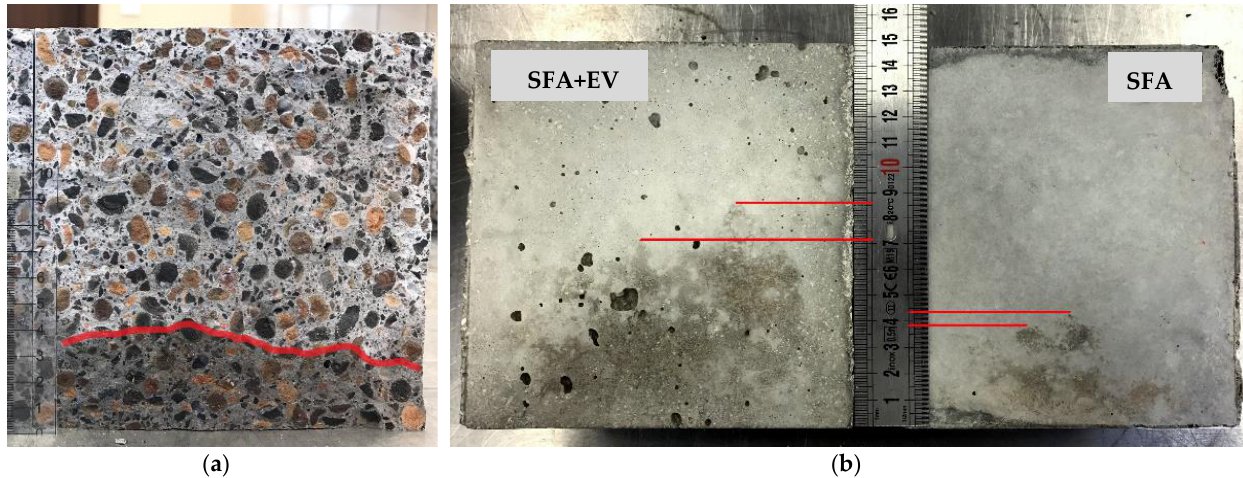
Figure 7. Depth of penetration of water under pressure: ( a ) cross-section of a specimens of SFA concrete; ( b ) surface of SFA+EV concrete and SFA concrete specimens after the test.